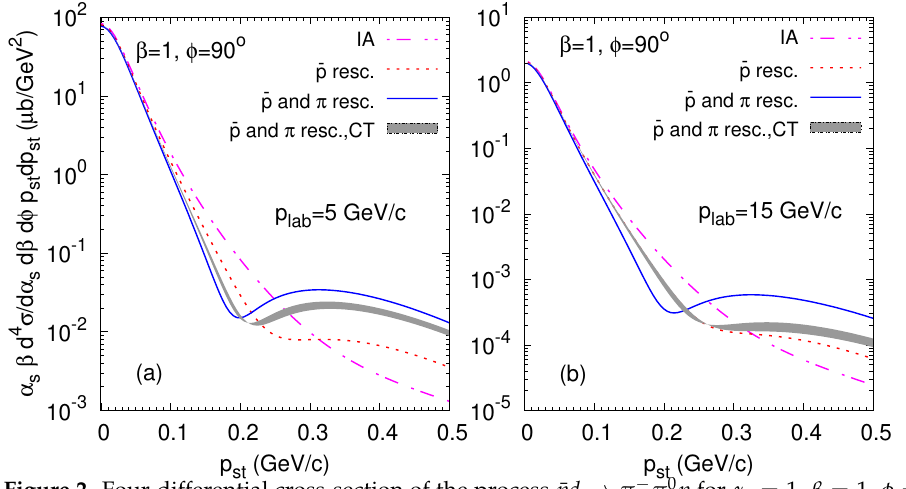
Figure 2. Four-differential cross-section of the process ¯ pd π − π 0 p for α s = 1, β = 1, φ = 90 ◦ at → the laboratory momentum ( a ) p lab = 5 GeV/ c and ( b ) p lab = 15 GeV/ c . Dash-dotted, dotted, and solid lines—IA, IA + ¯ p rescattering, IA + ¯ p and π rescattering, respectively. Grey band—IA + ¯ p and π rescattering with color transparency (CT). The band is limited by the values of the mass denominator of the coherence length ∆ M 2 = 0.7 GeV 2 and 1.1 GeV 2 . See text for details.